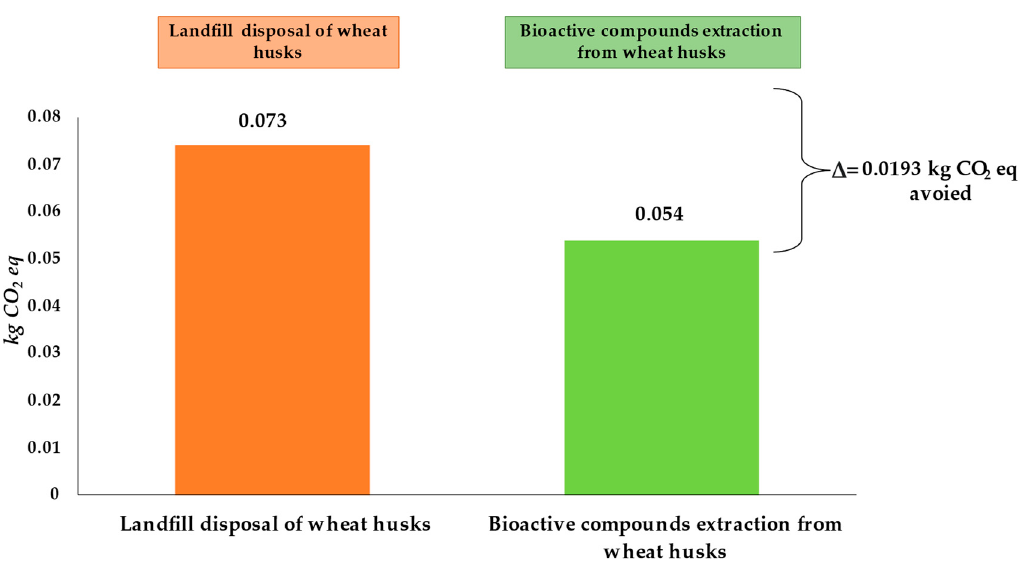
Figure 9. Carbon footprint of alternative scenarios for wheat husk system